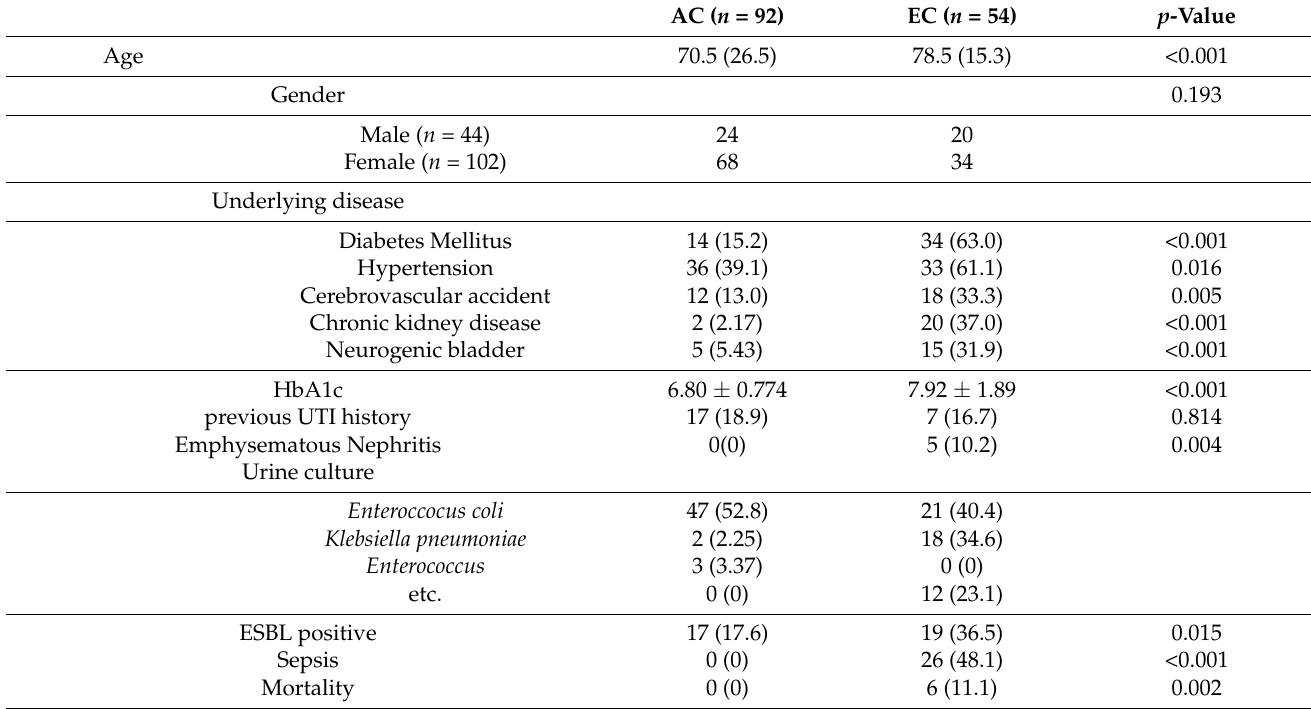
Table 1. Baseline characteristics of patients with EC and